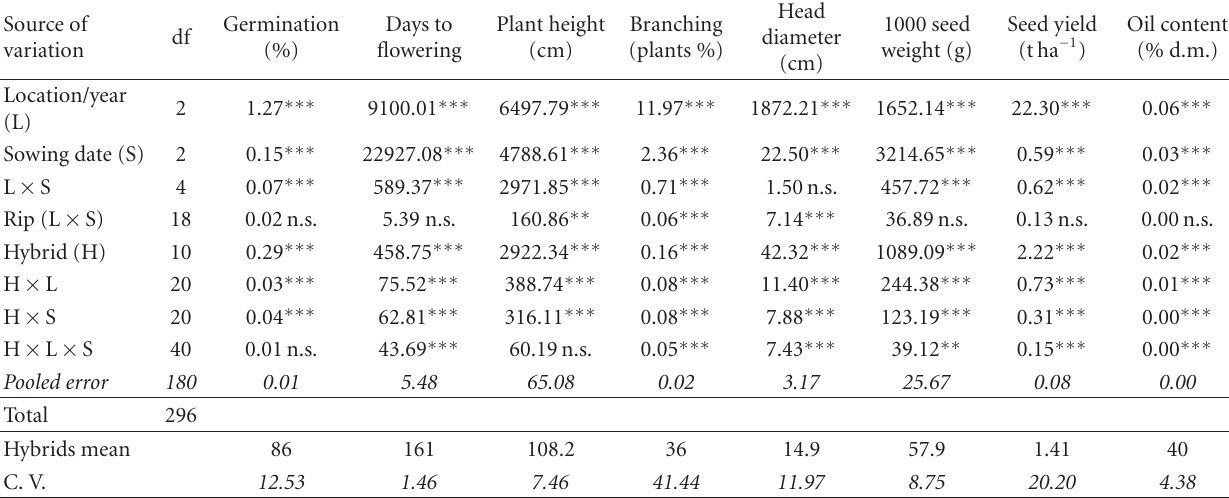
Table 3: Analysis of variance for eight biometric traits observed in 11 sunflower hybrids over three sowing dates (S) and three location-year combinations